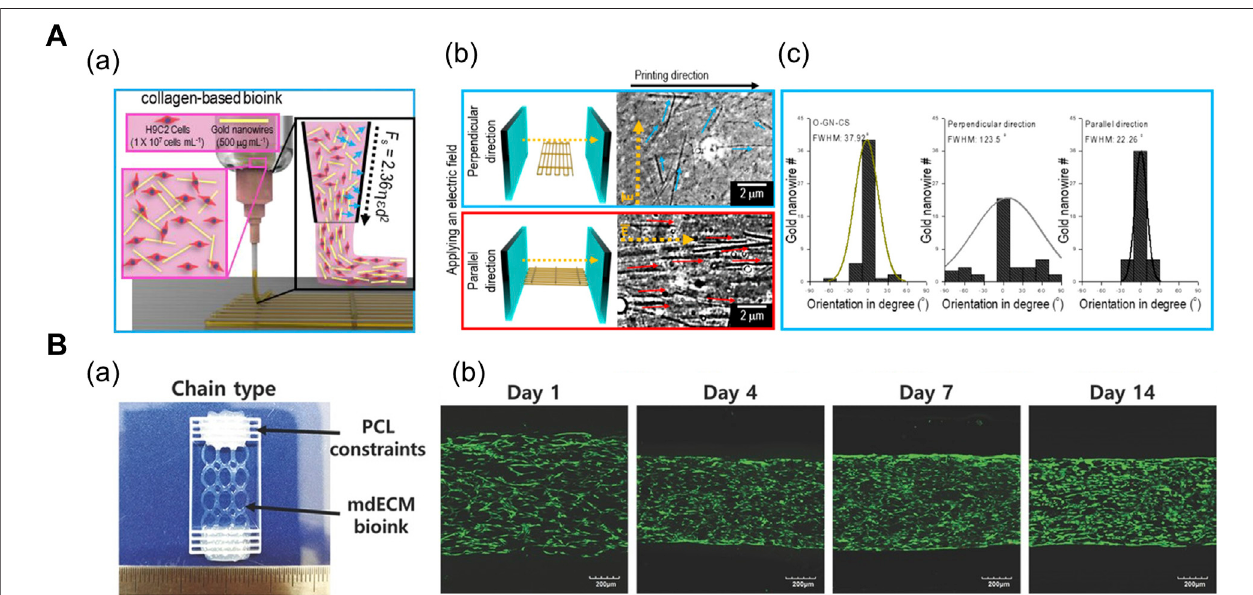
FIGURE 1 | (A) Shear force-mediated cell alignment method. (a) Schematic of cell alignment during the extrusion printing process with gold nanowires aligned along the printing direction. (b) Electric fi eld applied to promote the alignment of muscle cells through the alignment of gold nanowires. The optical images display the spatial distribution of gold nanowires under the electric fi eld in directions perpendicular and parallel to the printing direction. (c) Distribution of orientation of gold nanowires under three conditions: no applied electric fi eld (left), electric fi eld applied in directions perpendicular (middle) and parallel (right) to the printing direction. Reprinted with permission from (Kim et al., 2019). (B) 3D-printed anchor structure for applying tensile force. (a) 3D-printed muscle construct comprising geometric constraints and musclecell-laden mdECM bioinkin chain shape. (b) Live/dead stainingofprinted muscle constructs at Days 1, 4,7, and 14ofculture, revealing high cell viability ( > 90%) with minimal cell death. Construct compaction is accompanied by the longitudinal alignment of cells. Reprinted with permission from (Choi et al.,